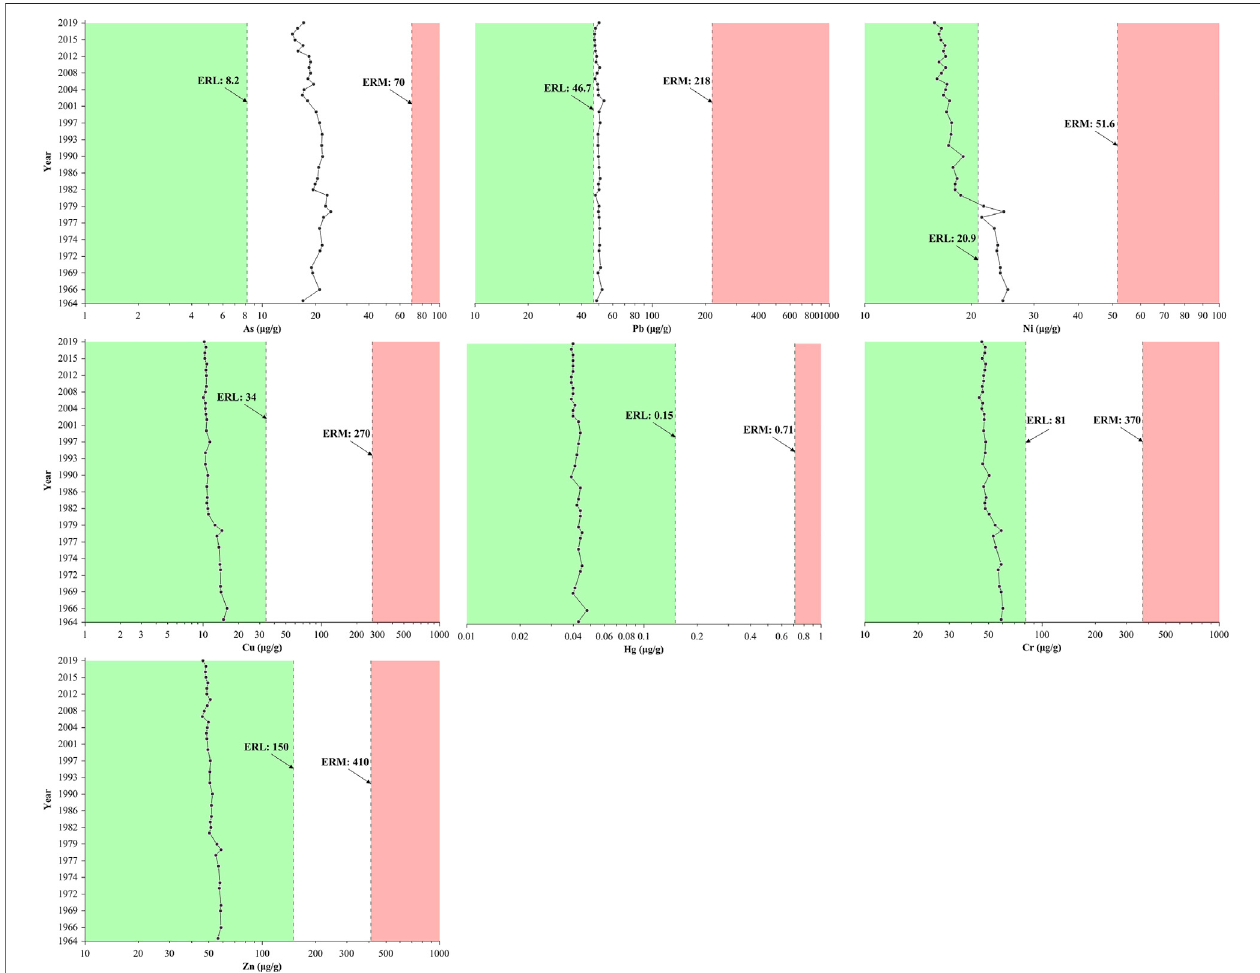
FIGURE 8 | Comparison of trace metals concentrations in sediment core SKL8-2 of Songkhla Lake with ERL (effects range low) and ERM (effects range median) guideline values. The green part below the ERL is where harmful effects on aquatic biota are rarely observed. The red area above the ERM indicates severe harmful